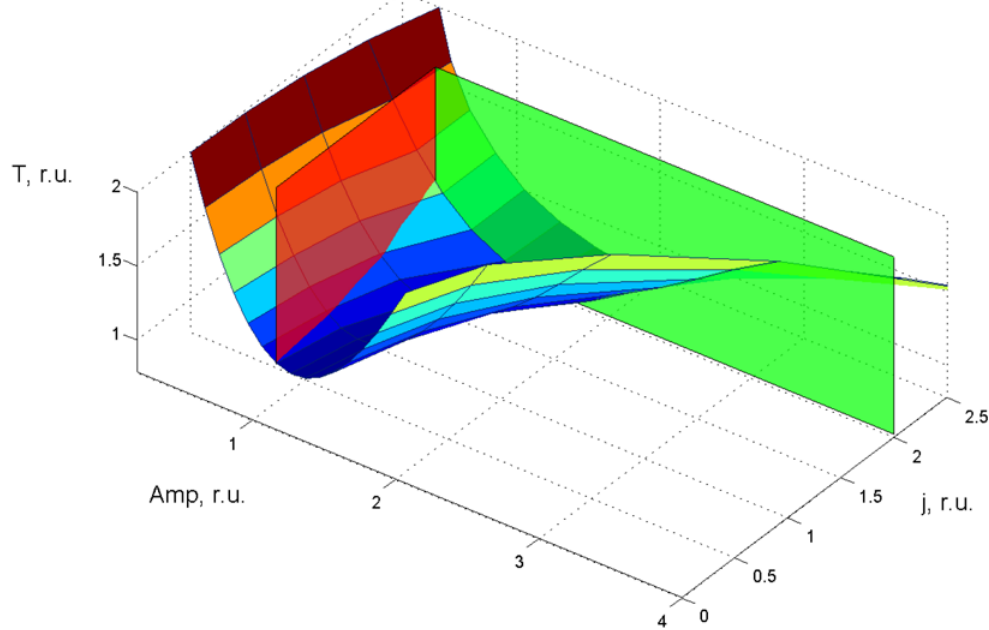
Figure 2. Dependency of the rms torque on the gear ratio of the mechanical converter and the amplitude of the resonant maximum of the frequency response.